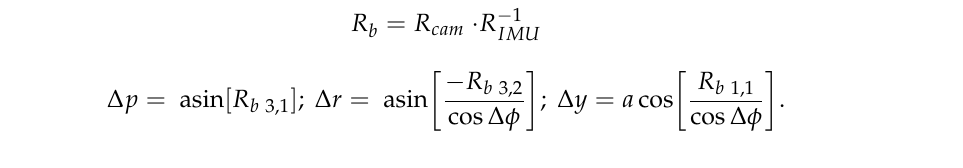
Table 3. Angular and positional offsets in the Personal Mobile Terrestrial